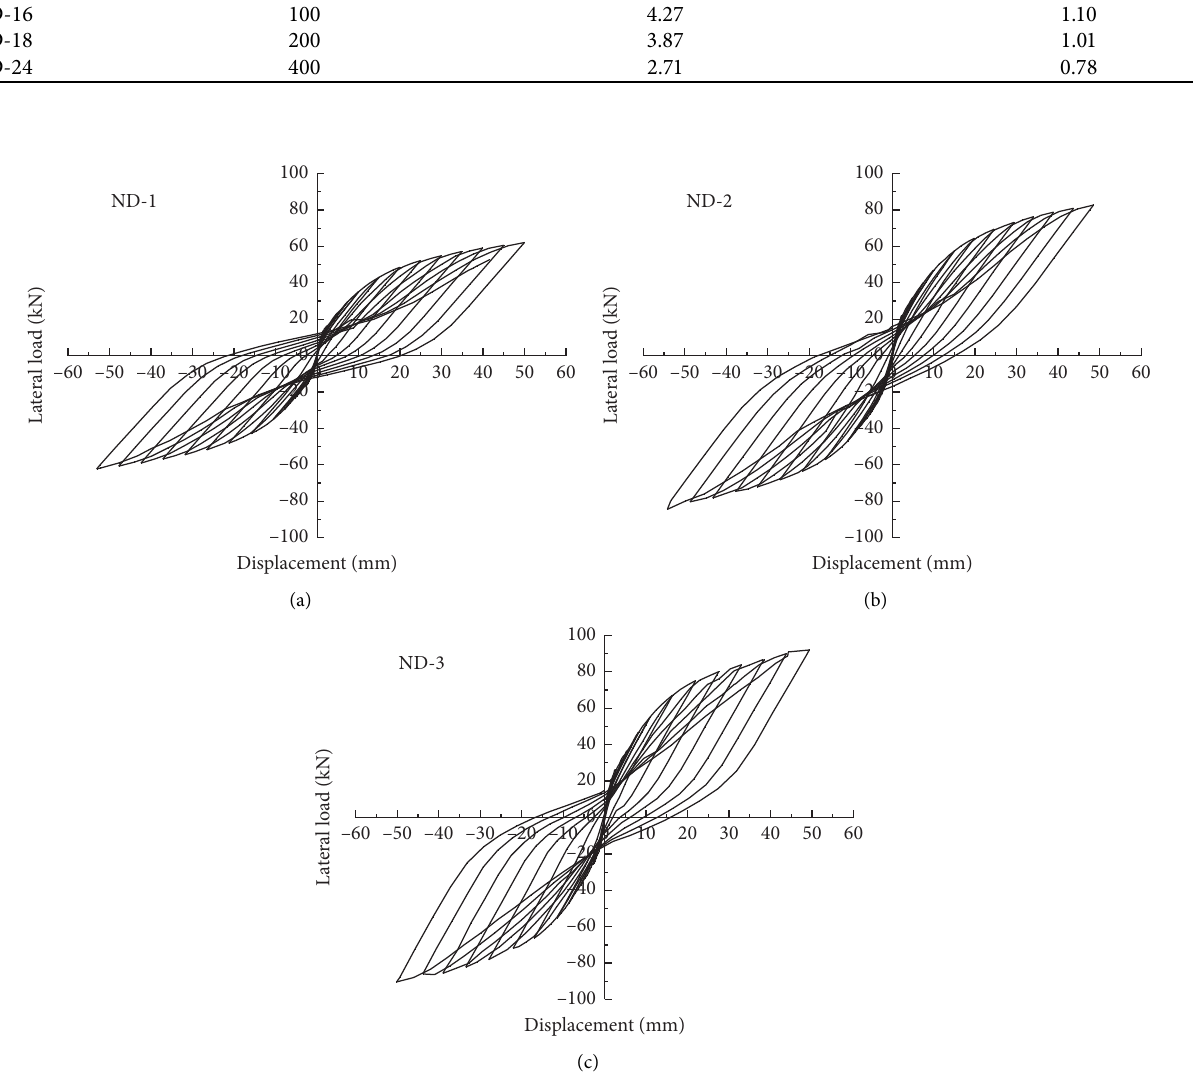
Figure 15: Hysteretic curves of slit width 5mm. (a) 0.4 mm. (b) 0.6mm. (c) 0.8mm.